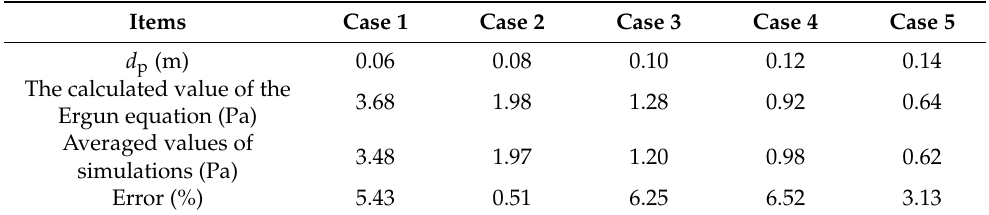
Table 3. Comparison of pressure drop with different coke diameters from the Ergun equation and simulations. Items Case 1